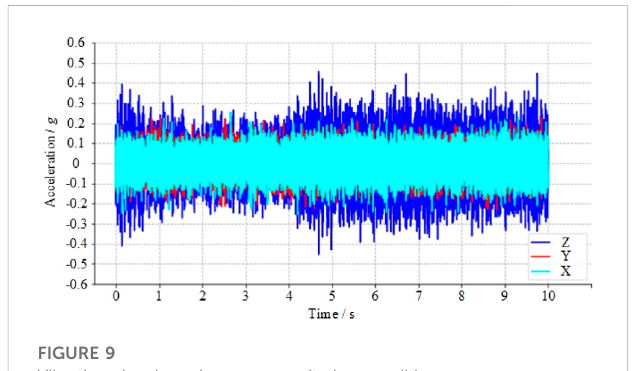
FIGURE 9 Vibration signals under severe cavitation